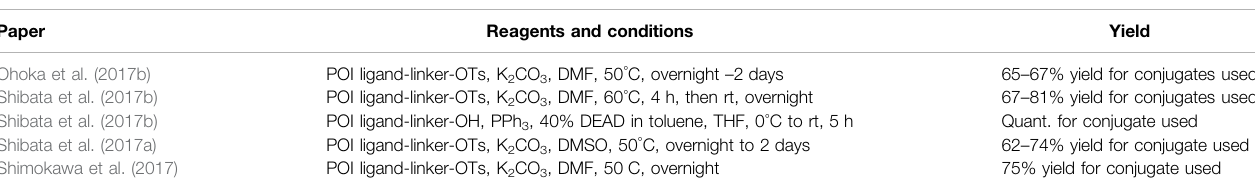
TABLE 8 | Reagents, conditions, and yields for the conversion of 220 to 221 ( Scheme 37 , step f). Paper Reagents and